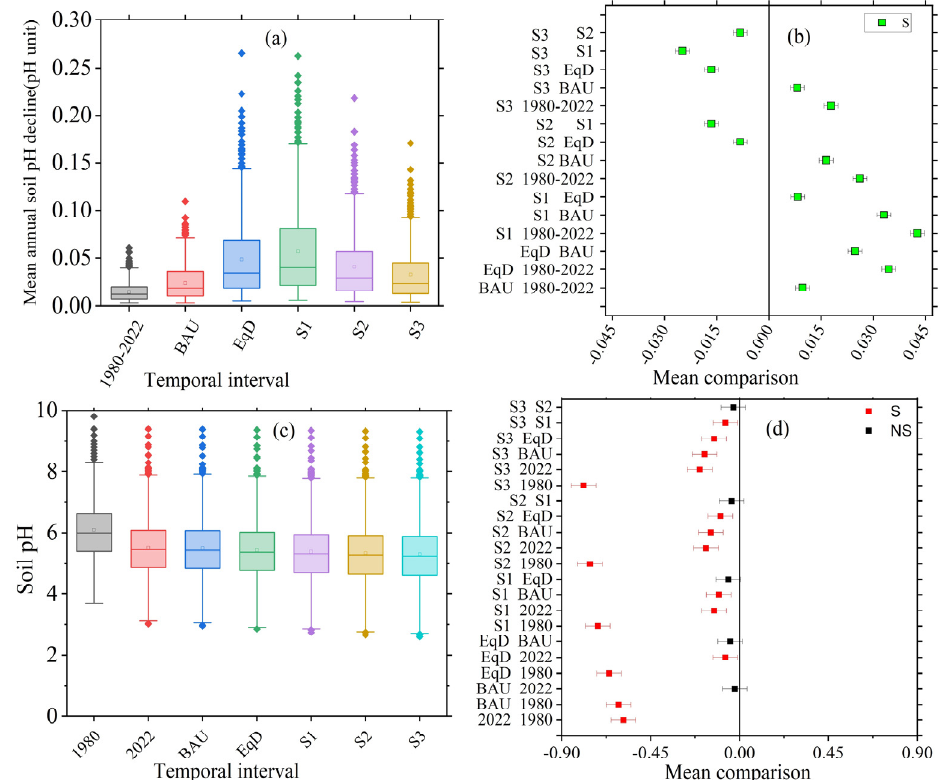
Figure 11. Comparison of past and predicted soil pH decline ( a , b ) and past and predicted soil pH ( c , d ). BAU: business-as-usual scenario (ammonium-based fertilizer and crop production for 2022 to 2050) followed the same trends as those of the last 42 years; EqD: equitable diet scenario (self-sufficiency); S1: increase of 20% in use of N fertilizers in the EqD scenario; S2: decrease of 20% in use of N fertilizers in the EqD scenario; S3: decrease of 40% in use of N fertilizers in the EqD scenario. Green (S) in figure ( b ) indicates statistical significance at a 95% confidence level, whereas black (NS) and red (S) indicate non-statistical significance (NS) and statistical significance (S), respectively, at a 95% confidence level.